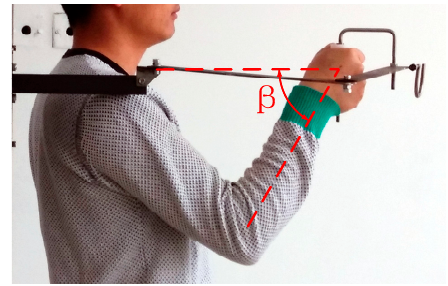
Figure 19. Maximum ulnar deviation position of the 3 ‐ DOF exoskeleton prototype.